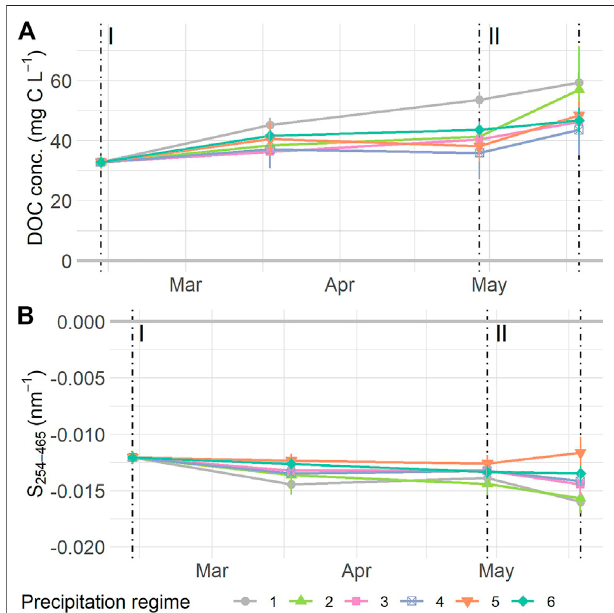
FIGURE 4 | Normalized dissolved organic carbon (DOC) concentration (A) and S 254 – 465 (B) measured at the start and middle of the resistance phase (I), the transition to and the end of the resilience phase (II). Values are means ± SE. A: n (cid:2) 118, B: n (cid:2) 114. For details on precipitation regimes, please see Figure 1 . NOTE: data depicted have been normalized, see Supplementary Figure S7 for uncorrected data.